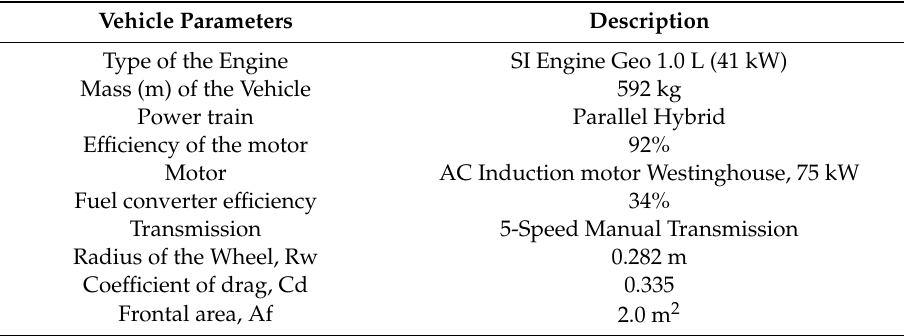
Table 1. Vehicle